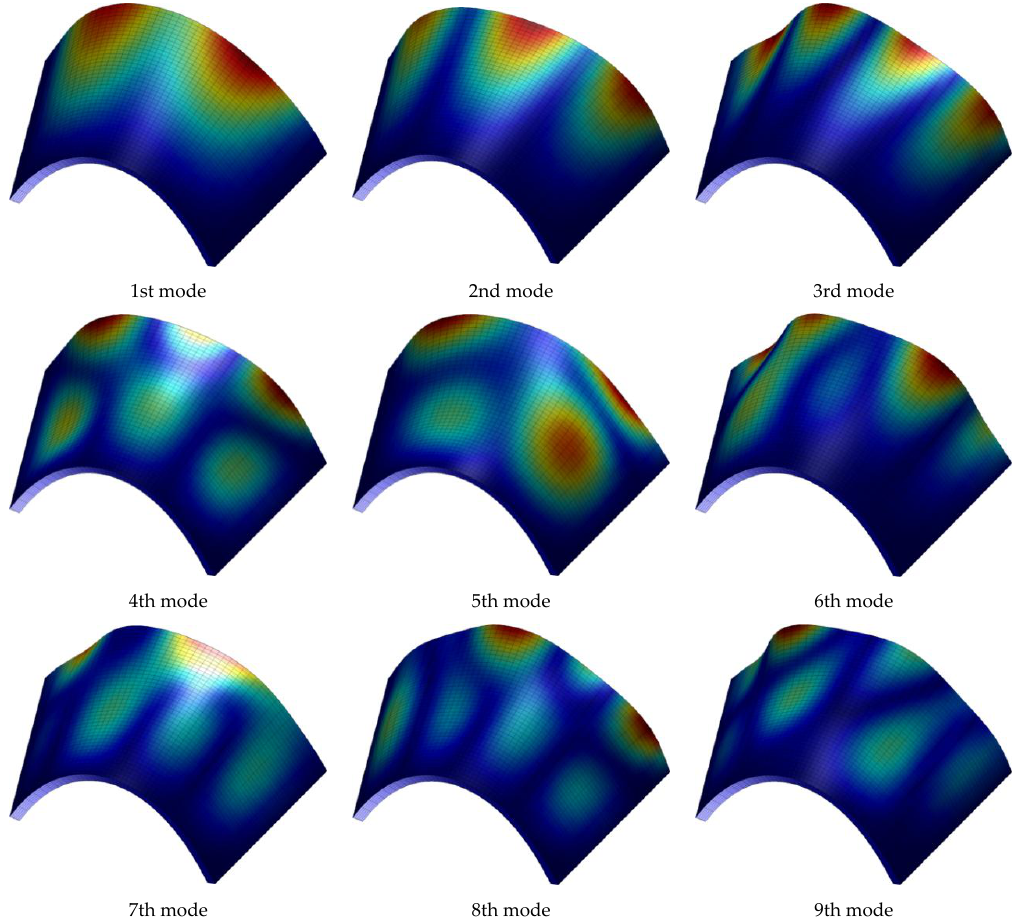
Figure 5. First nine mode shapes for a CCFC laminated cylindrical surface with ( 90/30/45/60/0 ) as lamination scheme.